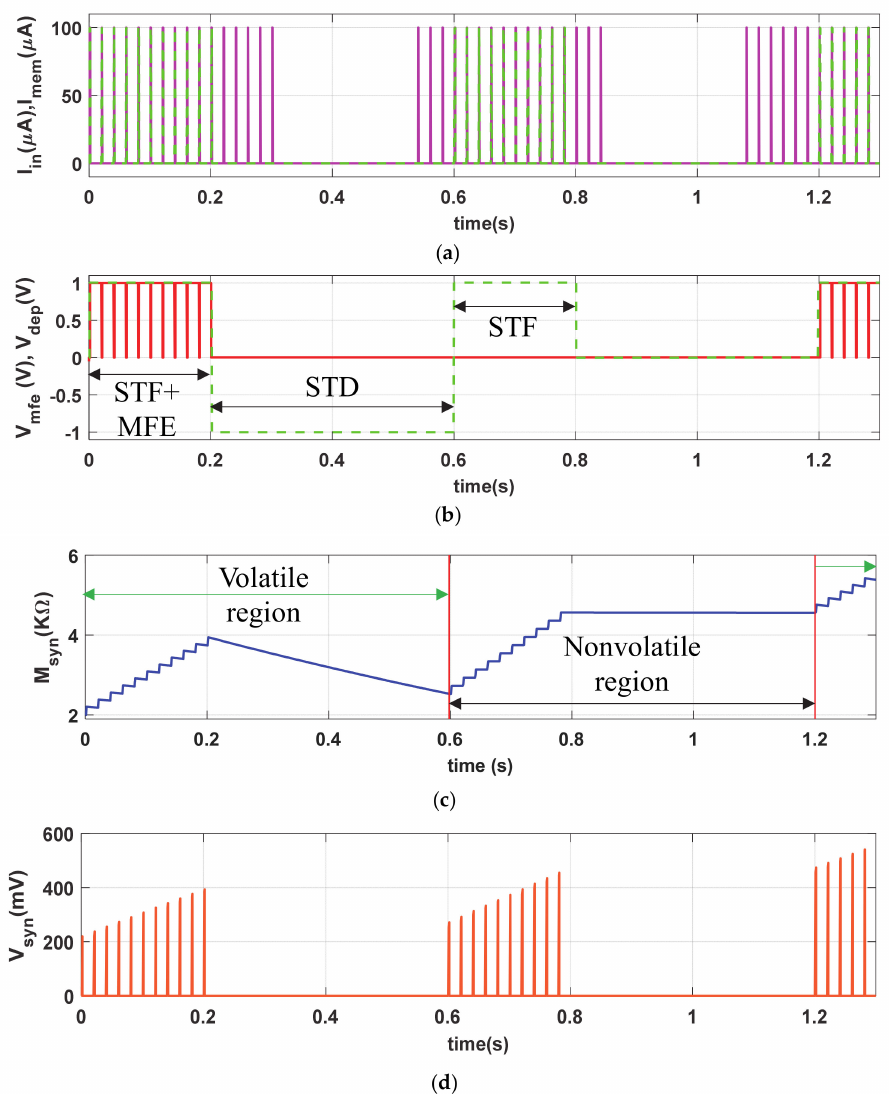
Figure 5. Volatile short-term facilitation (STF) and short-term depression STD, and nonvolatile synaptic responses of the proposed circuit. ( a ) Input stimulus (I in ) and current stimulus passes through proposed synapse (I mem ), ( b ) V mfe and V DEP signals, artificial synaptic ( c ) efficacy (M syn ), and ( d ) voltage (V syn